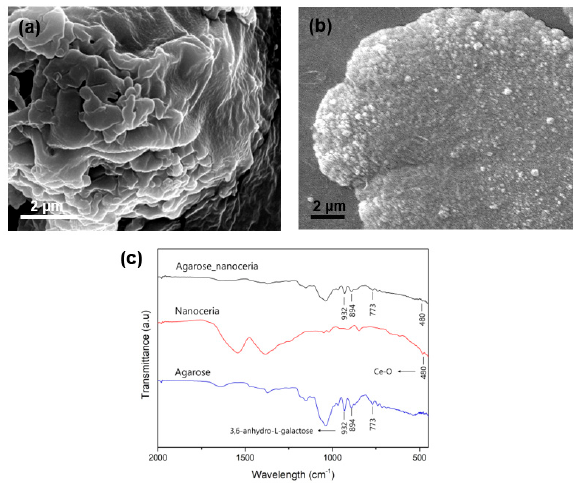
Figure 3. SEM images of ( a ) free agarose gel and ( b ) the agarose_nanoceria mixture. ( c ) FT-IR spectra of agarose_nanoceria, nanoceria, and agarose.